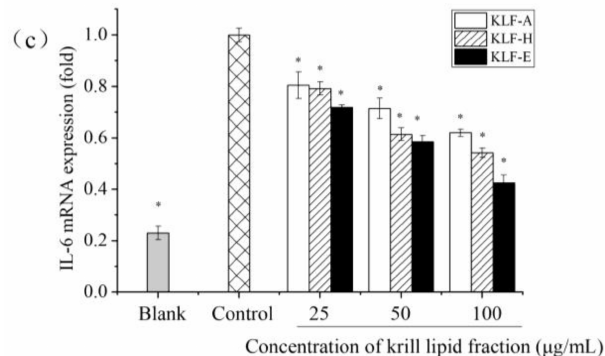
Figure 4. Effect of three krill lipid fractions on mRNA expression of cytokine ( a ) TNF- α , ( b ) IL-1 β and ( c ) IL-6 in RAW264.7 cells with LPS stimulation. Blank group referred to the untreated cells; cells treated with LPS alone were considered as the control group. * p < 0.05 versus the control group; one-way analysis of variance (ANOVA) combined with Duncan’s multiple-range test was used to analyze the significance. Abbreviations: LPS, lipopolysaccharide; KLF-A, the krill lipid fraction extracted with acetone in the first step; KLF-H, the krill lipid fraction extracted with hexane in the second step; KLF-E, the krill lipid fraction extracted with ethanol in the third